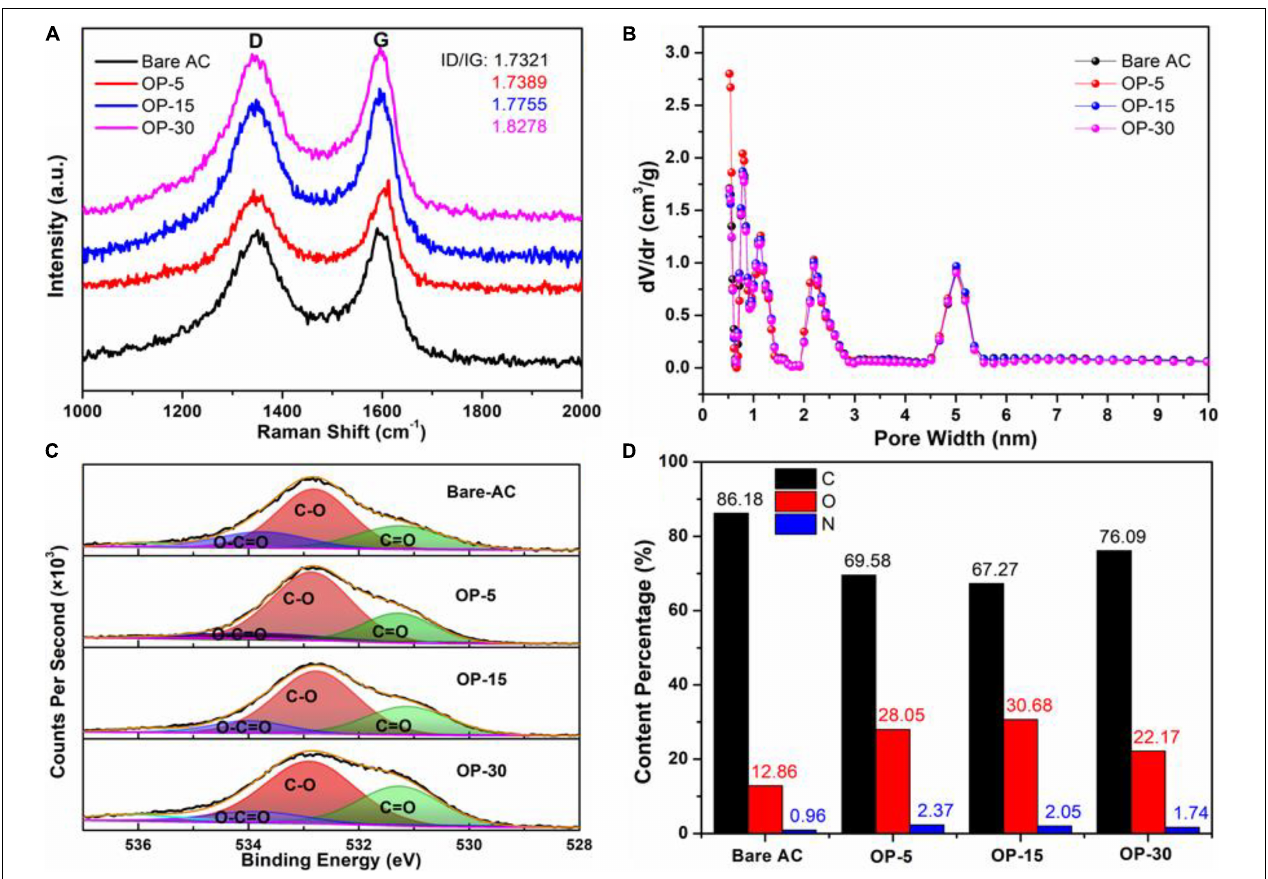
FIGURE 3 | (A) Raman spectra of Bare AC and OP-x; (B) the pore size distribution of Bare AC and OP-x; (C) Convolution peak of O1s spectra of Bare AC and OP-x; and (D) Element content percentage of Bare AC and